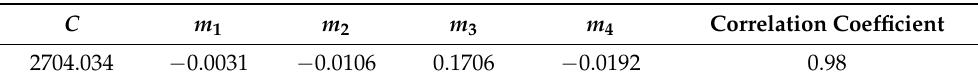
Table 4. Parameters of the deformation resistance model.